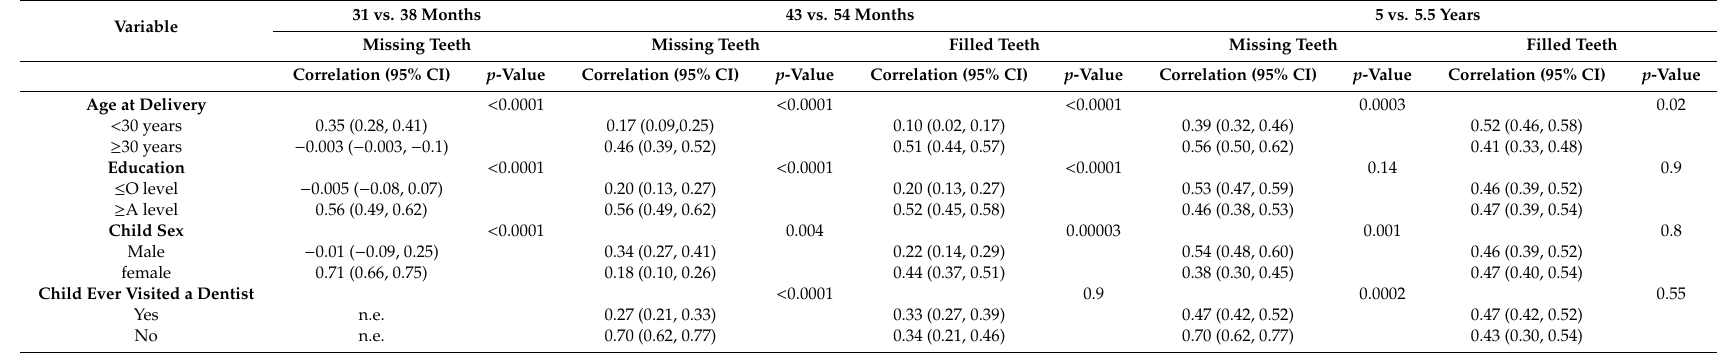
Table 5. Measures of correlation between subjective reports of missing and filled teeth with examiner determined missing and filled teeth at di ff erent time points, according to selected factors: Avon Longitudinal Study of Parents and